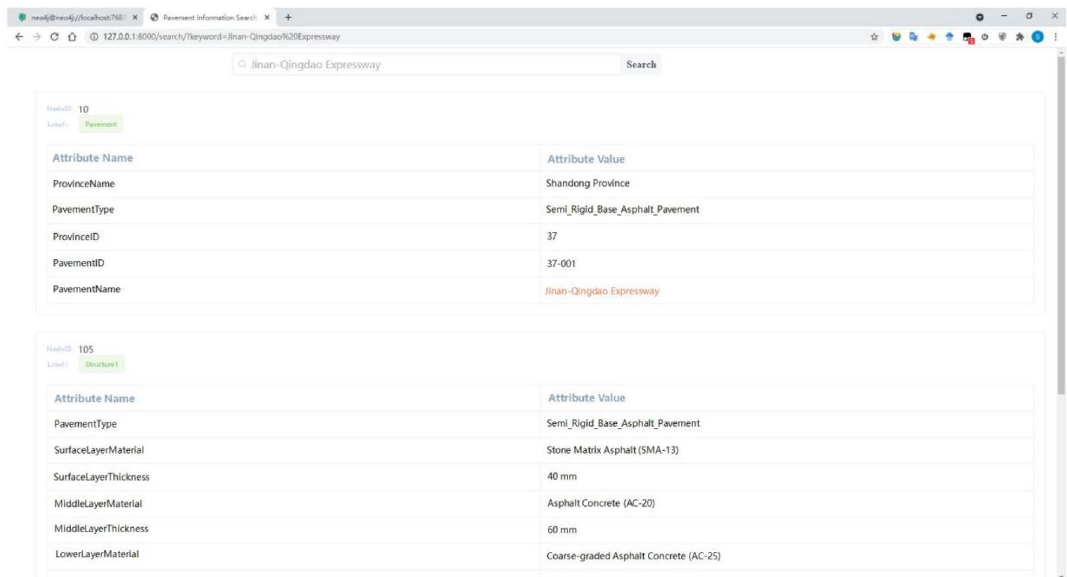
Figure 8. The display of pavement information search results.